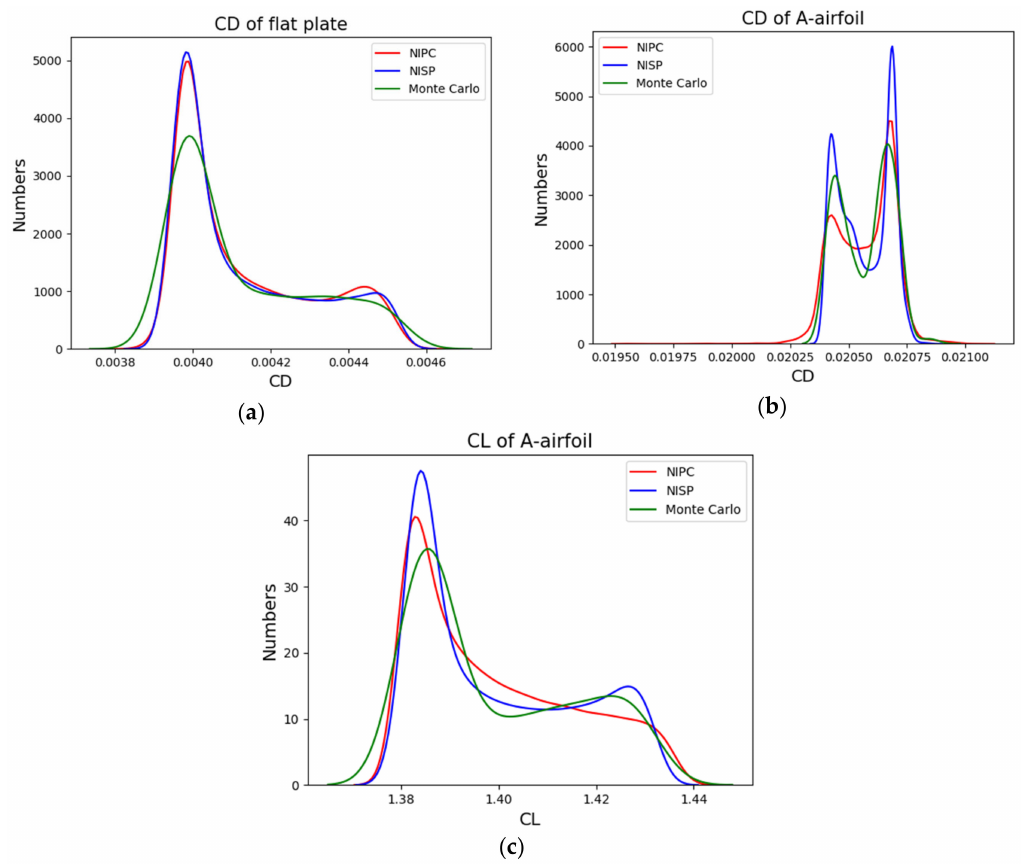
Figure 11. The distributions of the PDF at the fifth order of NIPC, NISP, and Monte Carlo (CL): ( a ) CD of flat plate; and ( b ) CD of A-airfoil, and ( c ) CL of A-airfoil.